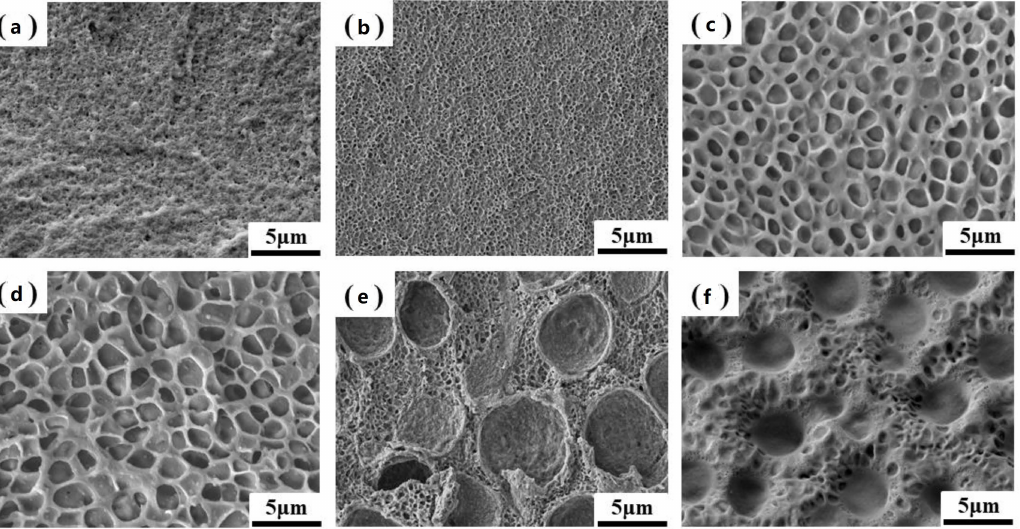
Figure 4. The microscopic morphology of the PDLC polymer matrix at various curing temperatures: ( a ) (50 ◦ C), ( b ) (40 ◦ C), ( c ) (30 ◦ C), ( d ) (20 ◦ C), ( e ) (10 ◦ C), ( f ) (0 ◦